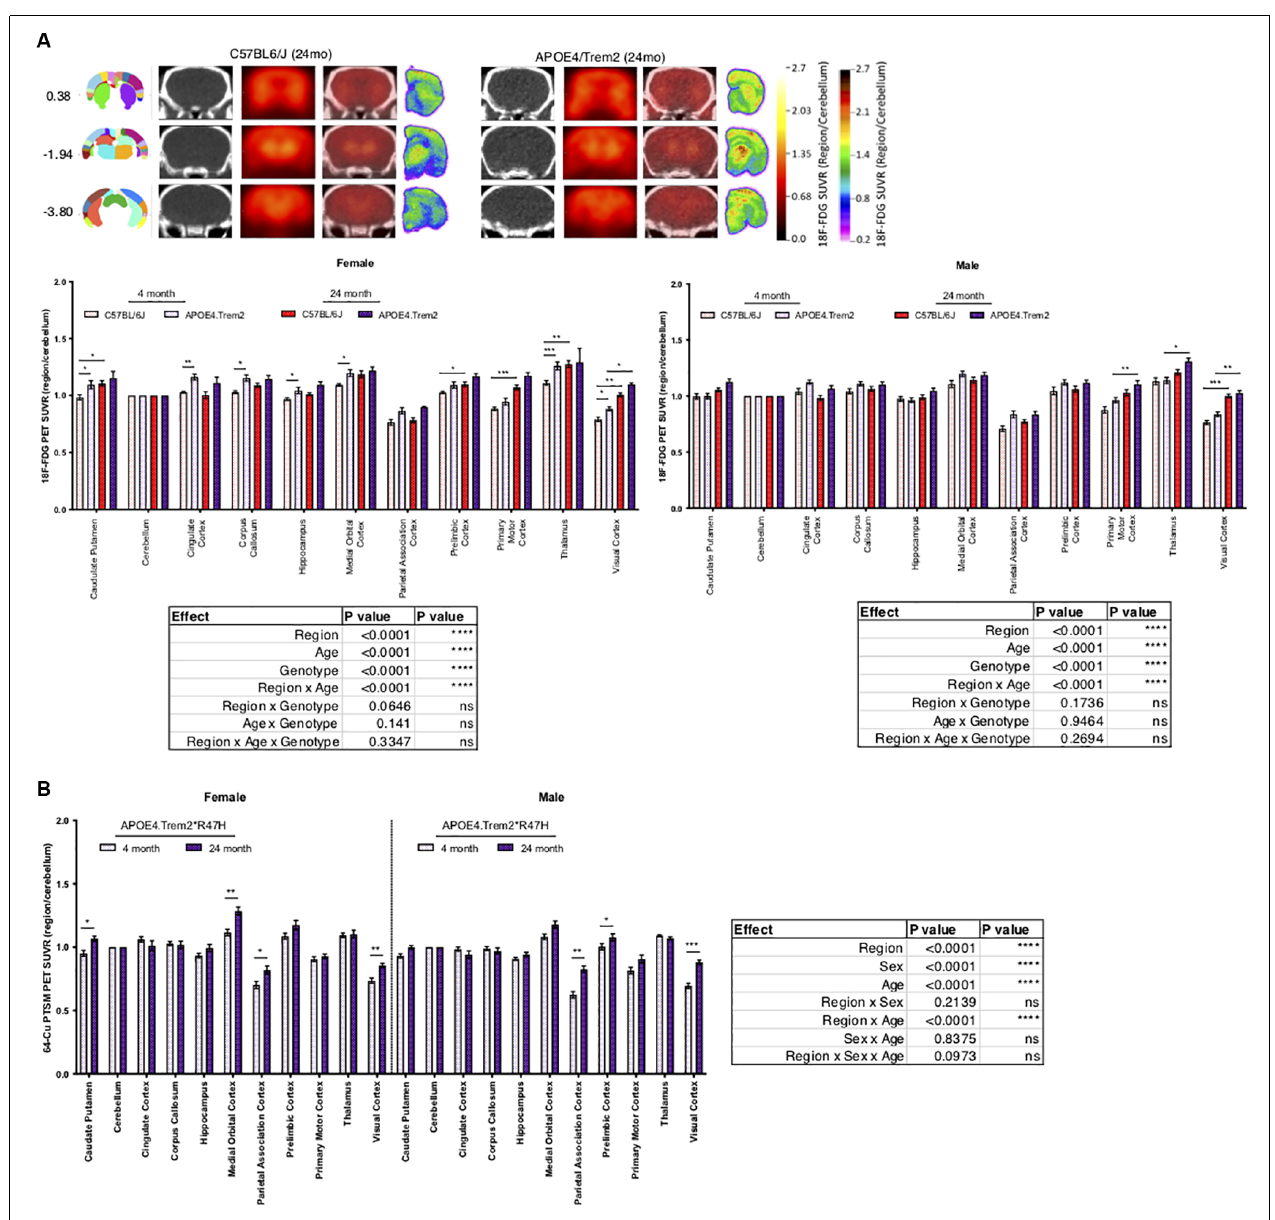
FIGURE 3 | Increases in regional glucose metabolism due to expression of APOE4 and Trem2*R47H . Positron emission tomography (PET; red scale) of radioactive 18F-FDG marker was used to measure tissue glucose uptake, guided by computed tomography (CT; black and white) mapping to brain regions of interest, indicated by bregma coordinates (far left) (A) . PET-CT of 64-Cu PTSM of female and male B6. APOE4.Trem2*R47H mice revealed age-driven increases in brain perfusion (B) . Post-mortem autoradiography of coronal brain tissue is represented in (A) (rainbow; far right). Genotype- and age-dependent differences determined by three-way ANOVA. Factor effects and effect interaction are displayed in tables. ∗ p < 0.05; ∗∗ p < 0.01; ∗∗∗ p < 0.001. All alleles expressed were